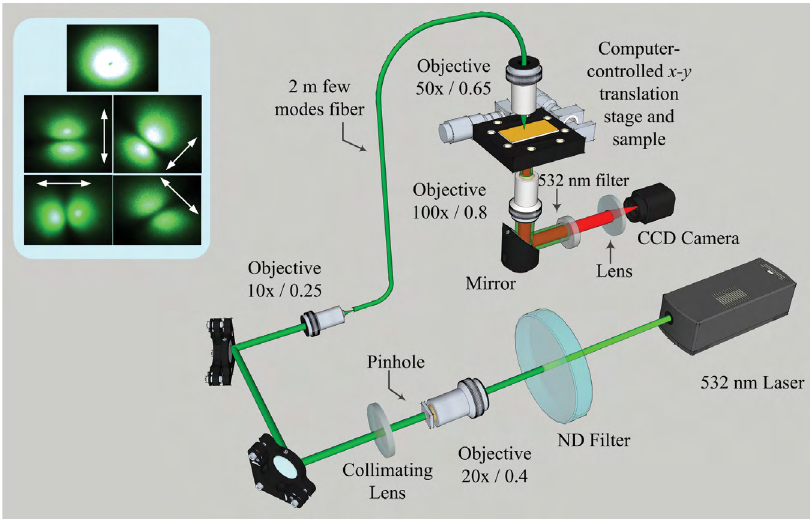
Figure 8 Experimental configuration. Inset shows the radially polarized beam generated at the end of the fiber, and the pictures of the beam after it passes through a linear polarizer orientated at different angles shown by the white arrows. Adapted from Ref.